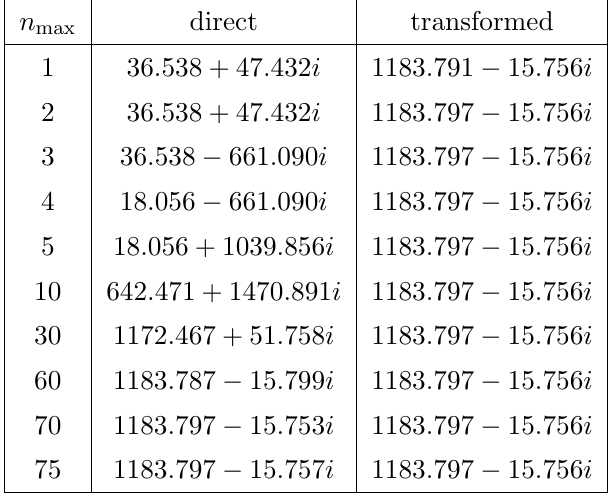
( (cid:28) ) at (cid:28) = 1 + i using a truncated q -expansion with 2 ; 1 ; 1 2 10 ( (cid:28) ) around (cid:28) = i 1 , while 2 ; 1 ; 1